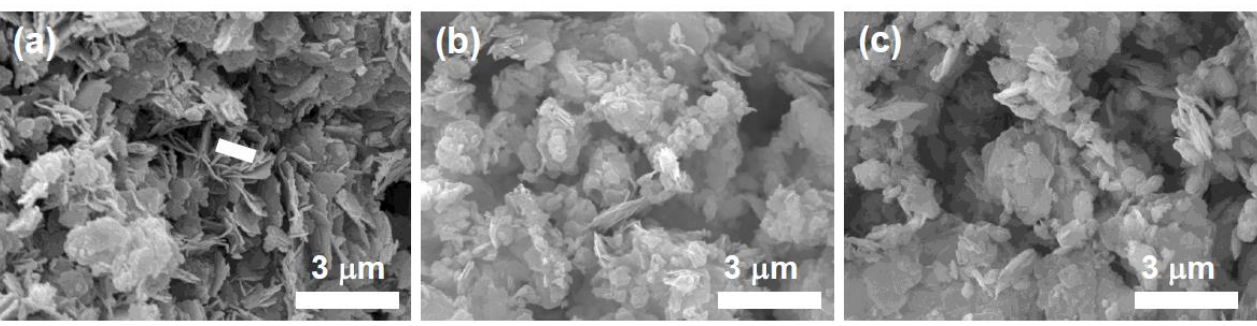
Figure 7. SEM images for CaFe LDHs with Ca/Fe ratios of ( a ) 2, ( b ) 3, ( c ) 4.